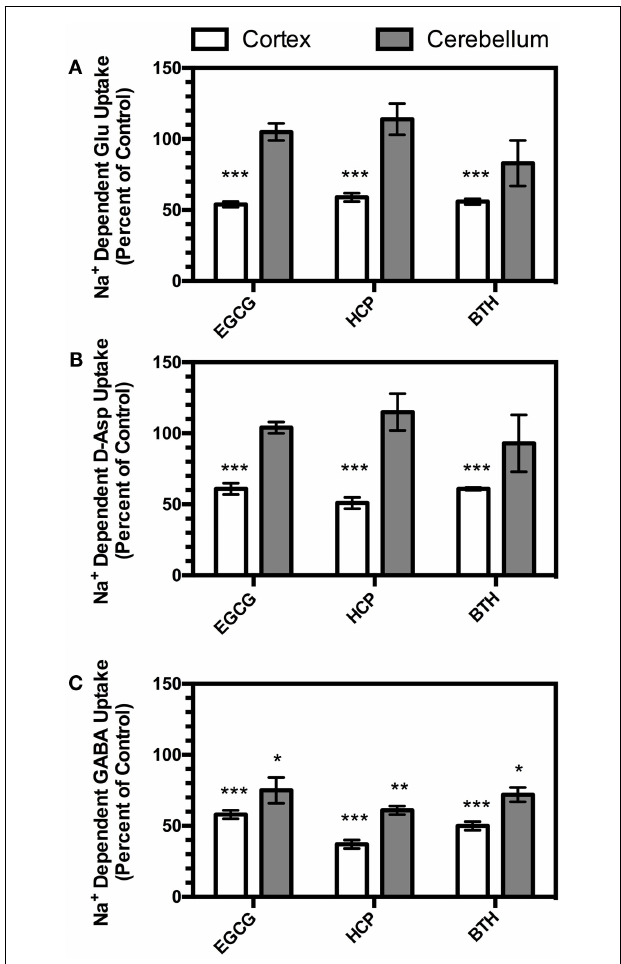
FIGURE 5 | Effects of EGCG (300 µ M), HCP (6 µ M), or BTH (3 µ M) on Na + -dependent transport of L -glutamate (A), D -aspartate (B), or GABA (C) measured in crude membranes (P2) prepared from cortex (open bars) or cerebellum (shaded bars) .Transport of all three substrates in both brain regions was measured in parallel experiments with different vehicle controls as described in the Section “Materials and Methods.” Data are the mean ± SEM from at least three independent experiments. Data were compared to vehicle controls by ANOVA. *Indicates a p < 0.05, ** indicates a p < 0.01, and *** indicates a p <